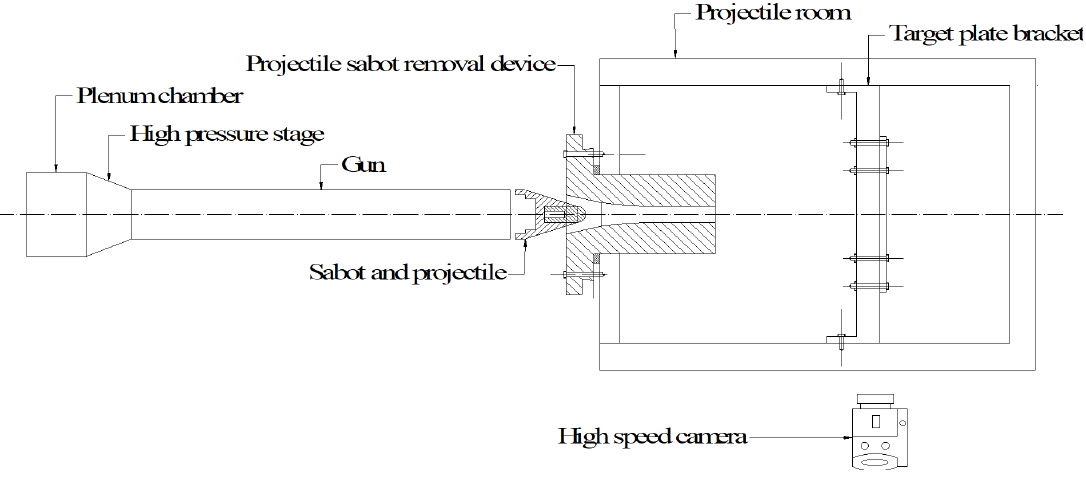
Figure 4: Sketch of experiment set-up